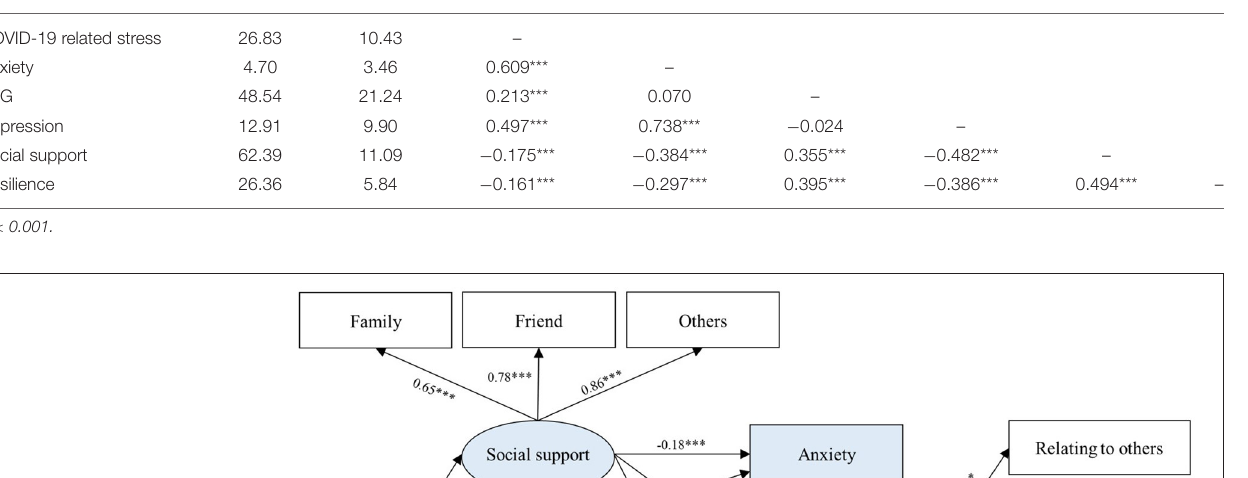
TABLE 2 | Descriptive statistics and correlations between key variables. Variable